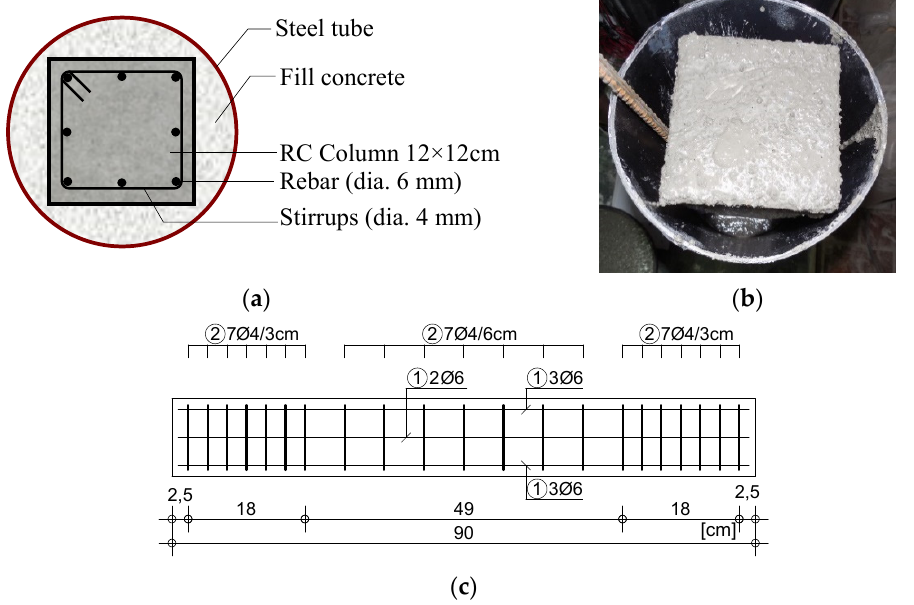
Figure 1. A schematic view of the strengthened column ( a ), a picture of pouring fresh concrete in a steel tube ( b ), and the reinforcement arrangement ( c ).